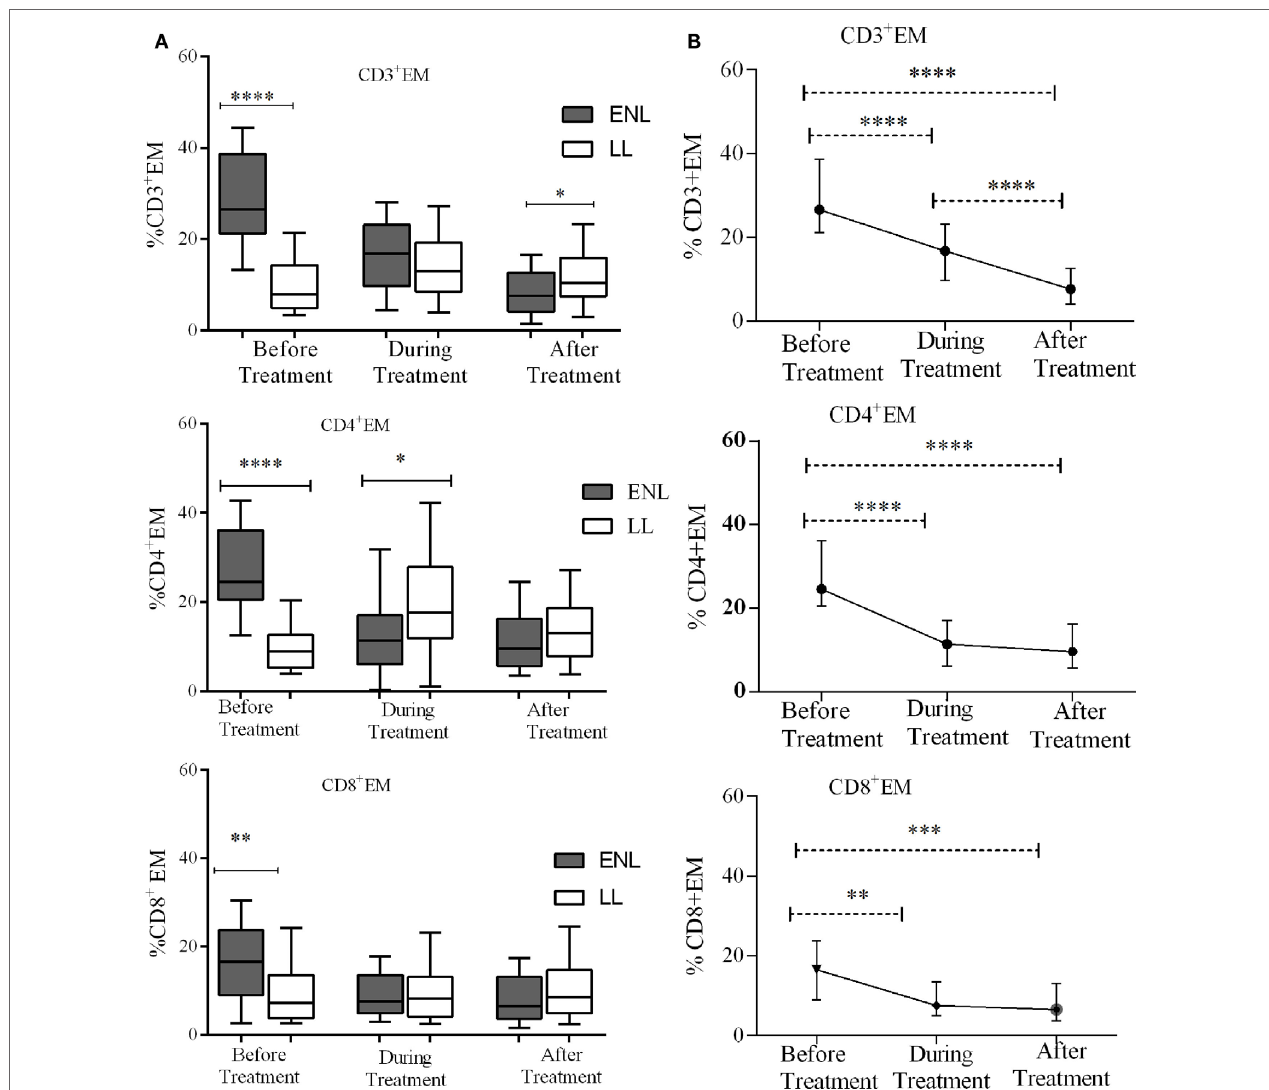
FigUre 4 | Median percentage of CD3 + , CD4 + , and CD8 + effector memory T-cells: (a) in patients with erythema nodosum leprosum (ENL) and lepromatous leprosy (LL) controls before, during and after treatment, (B) within ENL patients before, during, and after treatment. * P ≤ 0.05; ** P < 0.005; *** P < 0.001; **** P < 0.0001 . Box and whiskers (a) and error bars (B) show median ± interquartile